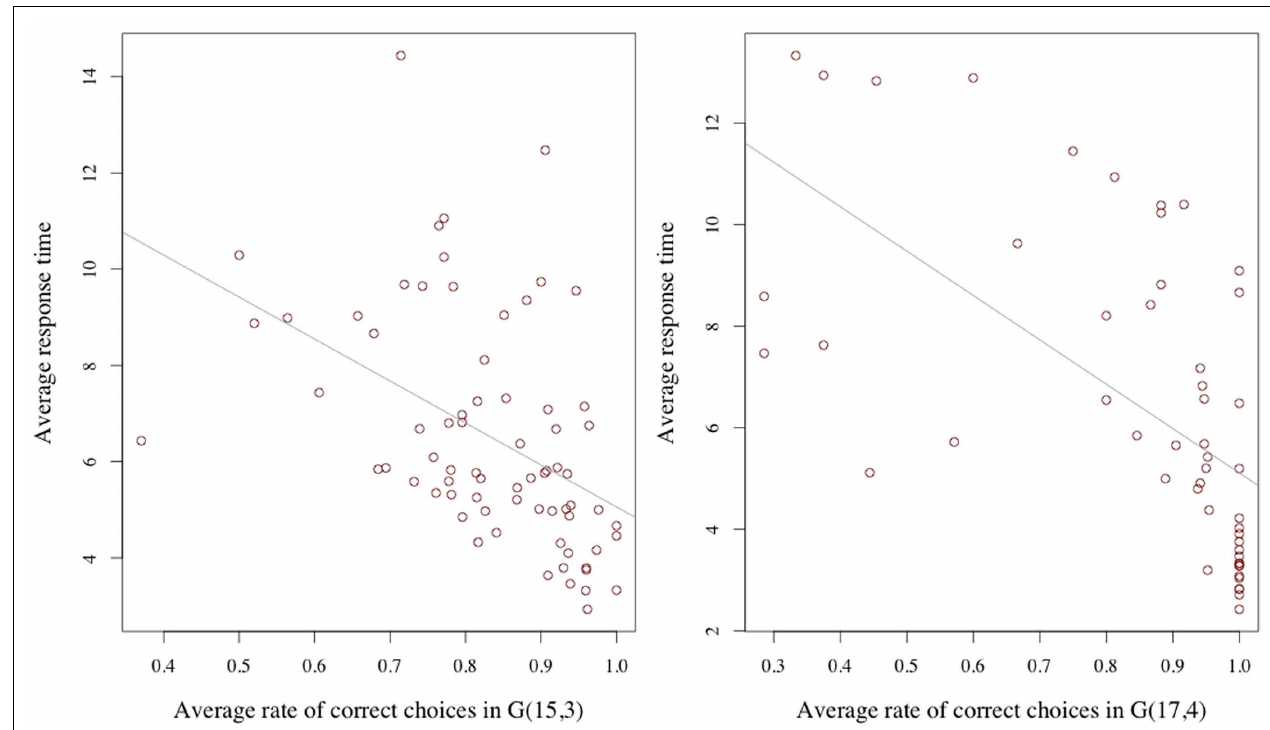
Table 1 |Average response time and average correct rate OLS for both games. RT 15 (b/se) RT 17 (b/se) Avg. correct G(15, 3) Constant 10.993*** (0.952) 0.252